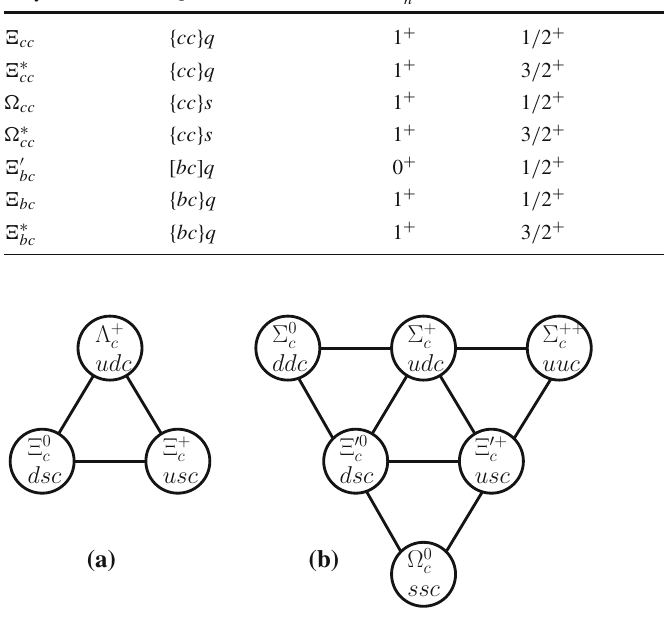
Fig. 1 The anti-triplet ( a ) and sextet ( b ) of charmed baryons. It is similar for bottom baryons